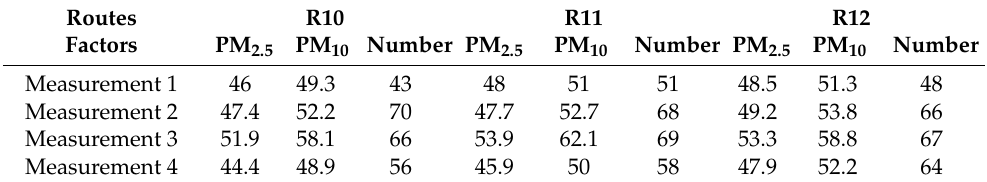
R10 represents route 10; R11 represents route 11; R12 represents route 12. Table A4. Average PM 2.5 , PM 10 concentrations ( µ g/m 3 ) and passenger number in the metro carriage on some additional routes.